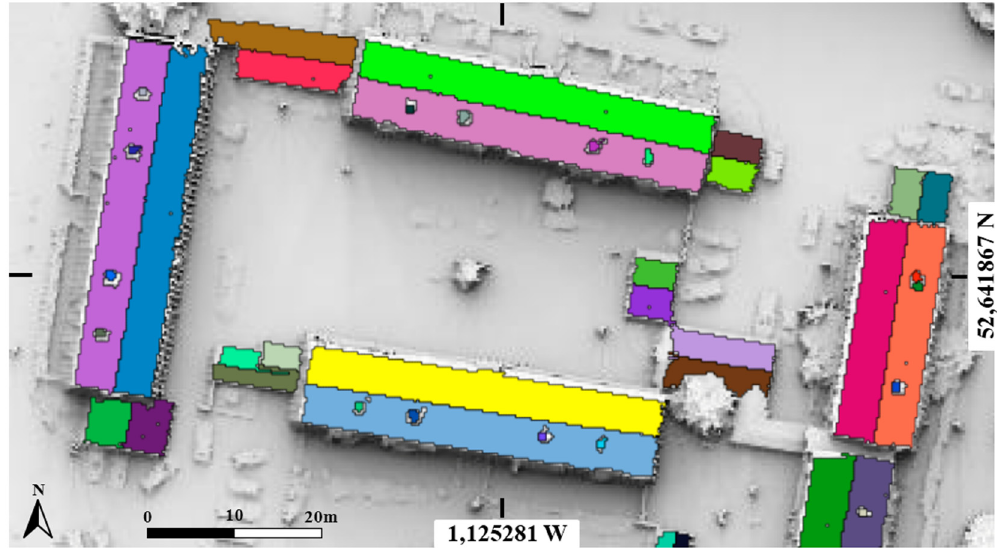
Figure 5. Roof planes extracted by the EAGLE approach from LiDAR data of a subset of the Leicester (UK) test site, DSM raster: 0.25 m, Copyright © Bluesky International Ltd. (Leicestershire, UK).